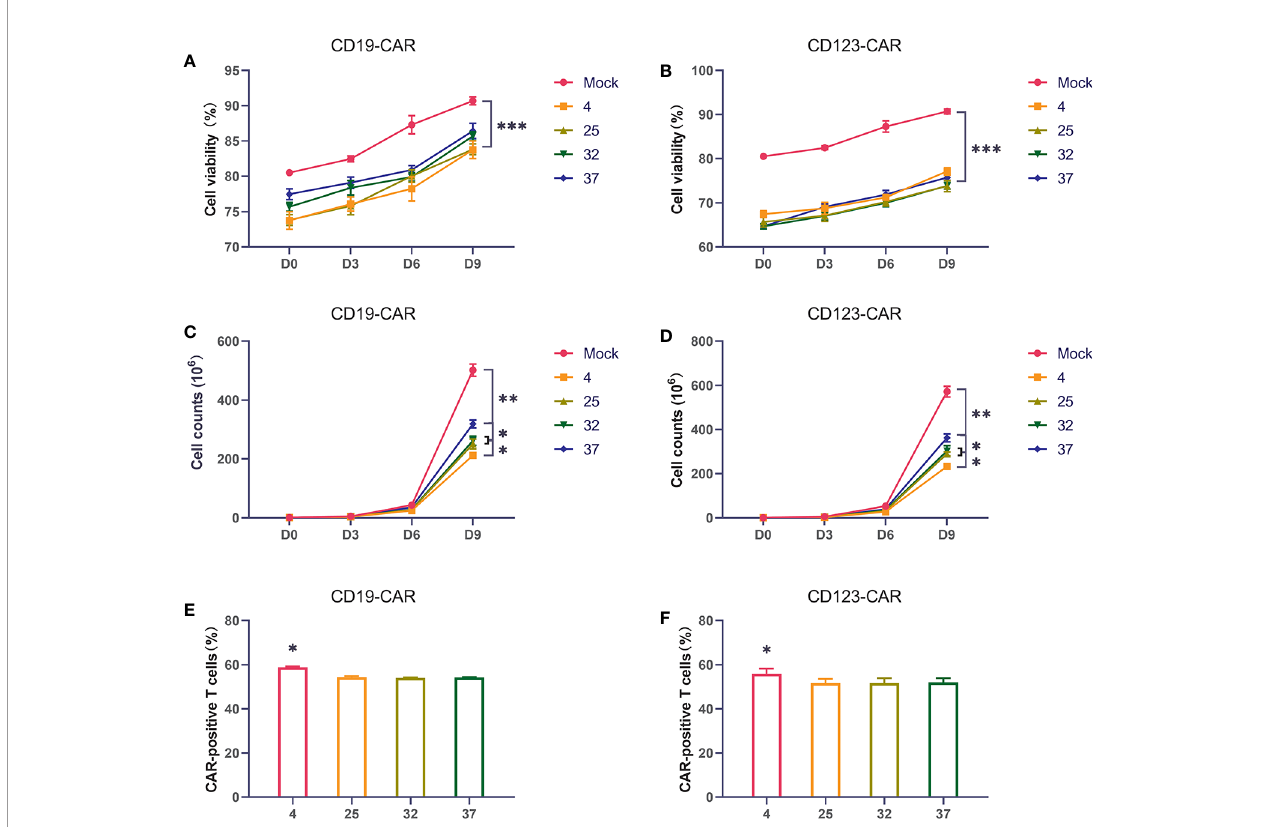
FIGURE 2 | Infection temperature can affect the proliferation and infection ef fi ciency of CAR-T cells (A, B) The proportion of living CD19 and CD123 CAR-T cells produced at different infection temperatures on the fi rst day, the third day, the sixth day, and the ninth day after infection. (C, D) The number of living CD19 and CD123 CAR-T cells produced at different infection temperatures on the fi rst day, the third day, the sixth day, and the ninth day after infection. (E, F) The infection ef fi ciency of CD19 and CD123 CAR-T cells produced at different infection temperatures. Three independent experiments were conducted. Mean ± SD. *p < 0.05, **p < 0.01, ***p <